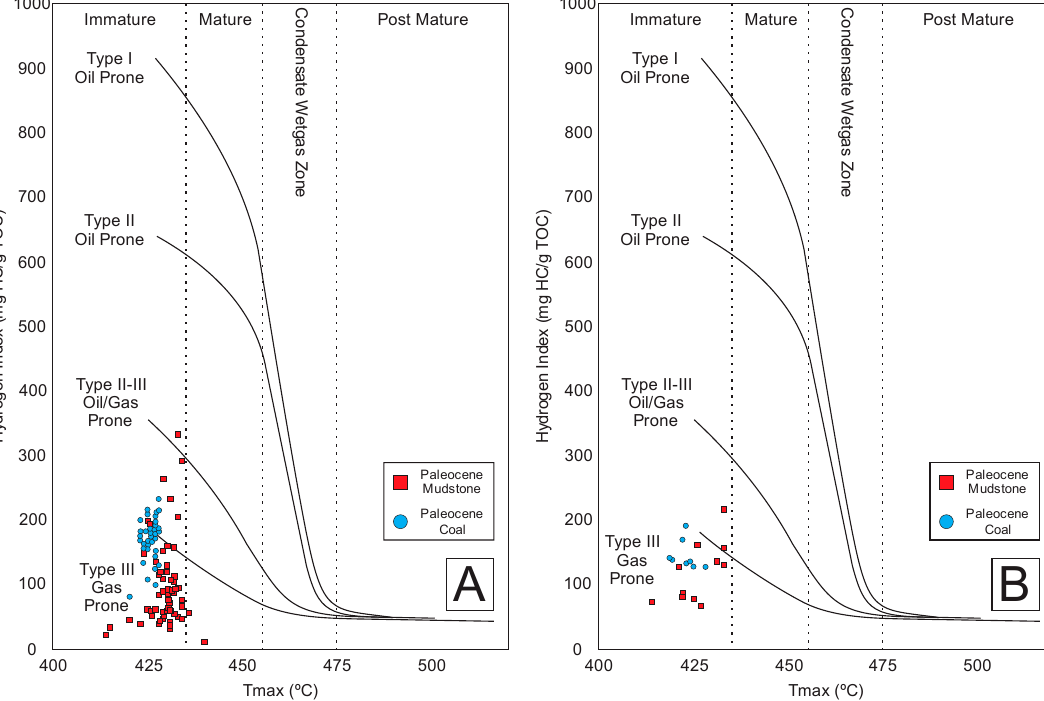
Figure 11. Cross plot of S2 versus total organic carbon (TOC) to exhibit the generating potential of the Cerrejón Formation in the ( A ) ANH-CARRETALITO-1 and ( B ) ANH-CAÑABOBA-1 wells.